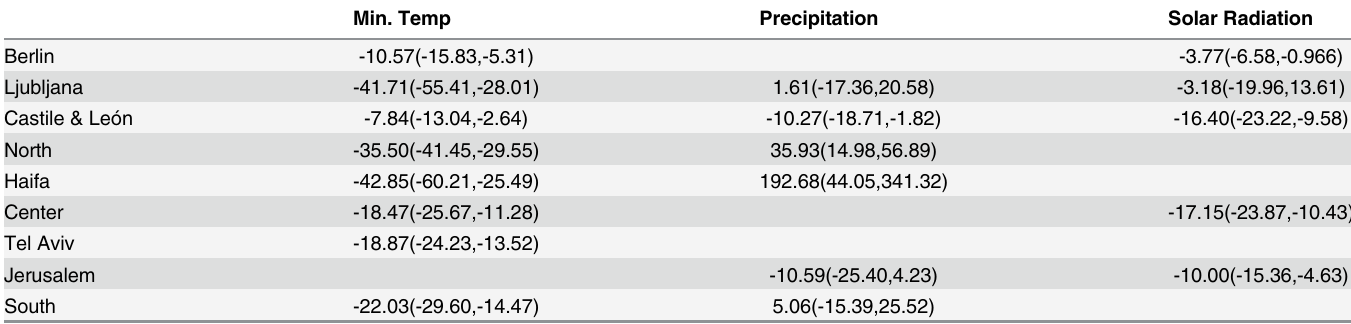
Table 5. Percentage change in influenza-associated ILI or ARI per 100,000 populations when one of the meteorological variables was increased from its median value by 10% of its range during epidemic weeks (Model 2). Min.